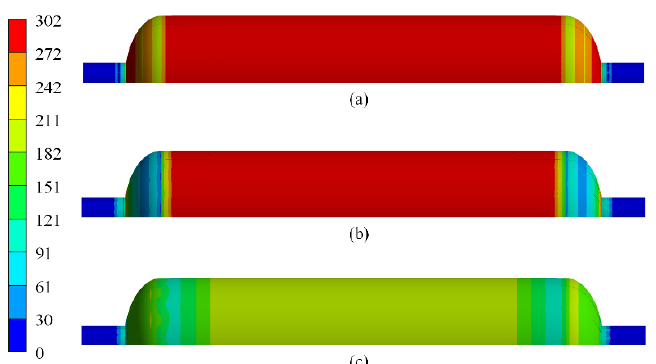
Figure 18. Numerical results of loading history of the aluminum liner at ( a ) service pressure before autofrettage, ( b ) zero pressure after autofrettage, and ( c ) service pressure after autofrettage.